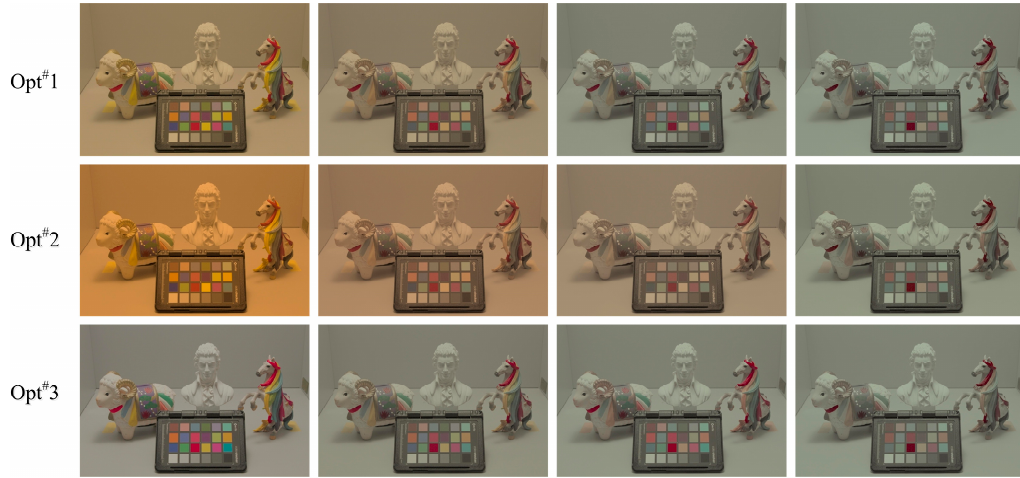
Figure 8. Simulated images of optimal SPDs (left to right: 10, 1, 0.3, and 0.1 cd/m 2 ).